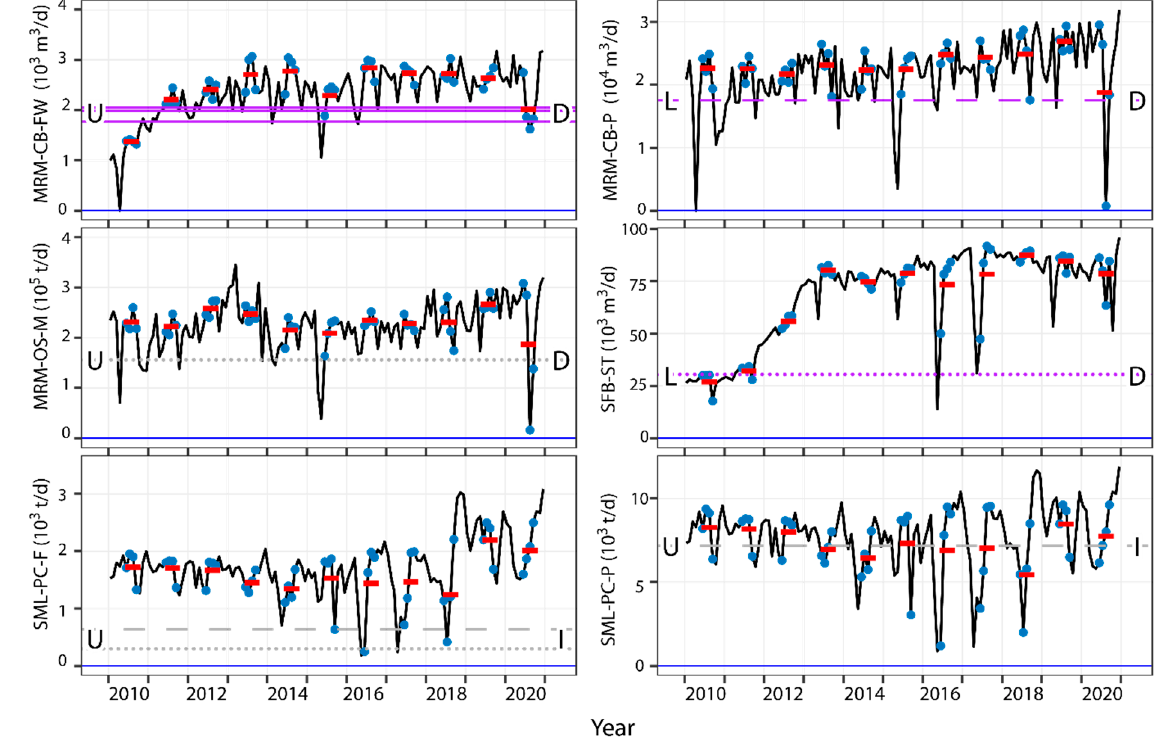
Figure 4. Effect size plots from zero industrial activity (horizontal blue lines) with greater or lesser industrial activities; purple lines = females; dark gray = males; solid lines = gonad weight; dashed lines = liver weight; dotted lines = body weight; L = Lower site; U = Upper site; D = decrease in fish measurement; I = increase in fish measurement; black lines = mean daily industrial metrics from 2010 ‐ 2020; blue dotes = June, July, August, September; Red lines = mean summer values for industrial endpoints.